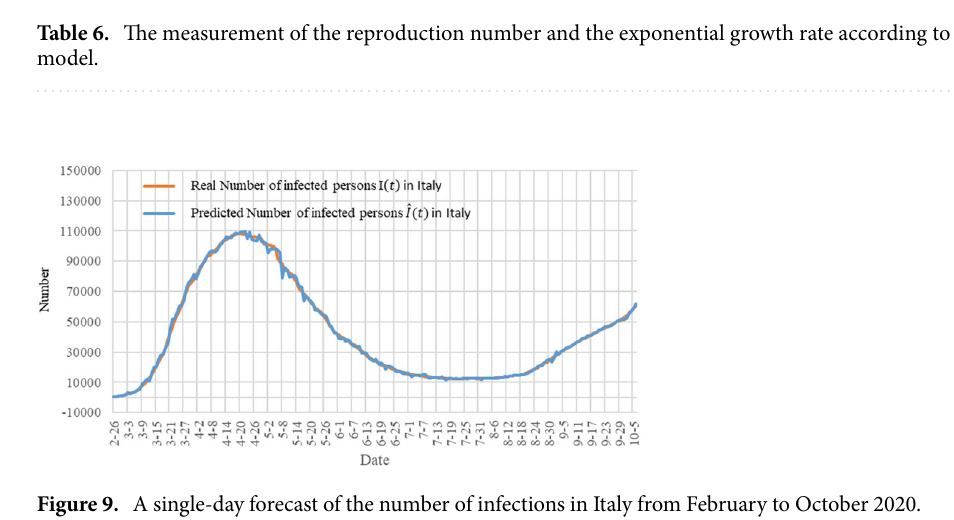
Figure 9. A single-day forecast of the number of infections in Italy from February to October 2020.